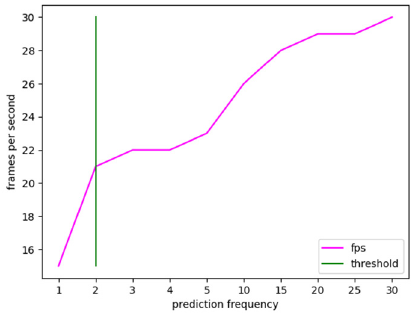
Figure 5. Frame rate trend versus prediction refresh rate calculated on a test video stream. The value 2 was experimentally chosen as the optimal tradeoff between real-time and accuracy.